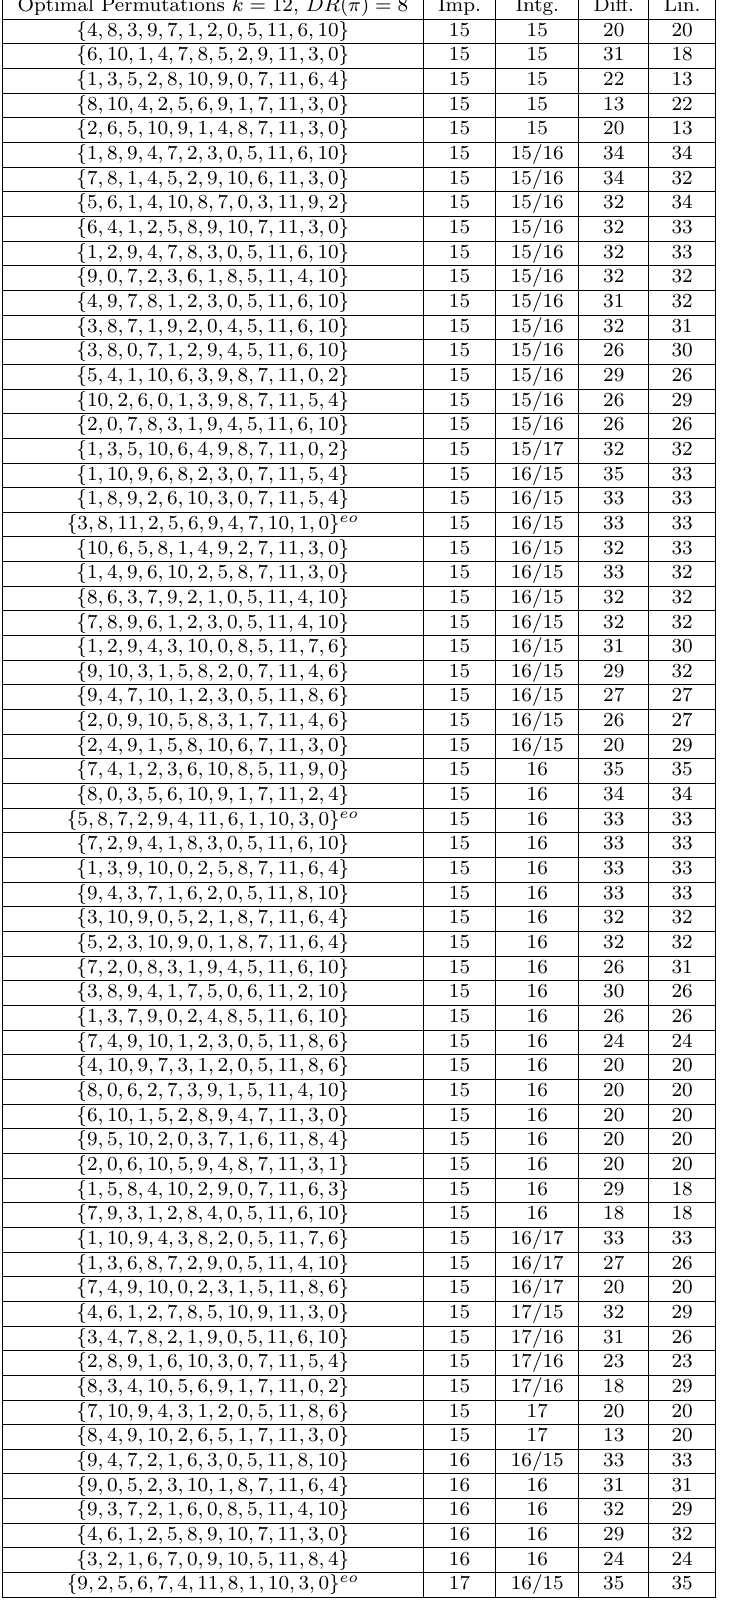
Table 14: Optimal permutations for k = 12 up to extended pair-equivalence (continued) Optimal Permutations k = 12, DR ( π ) = 8 Imp. Intg.